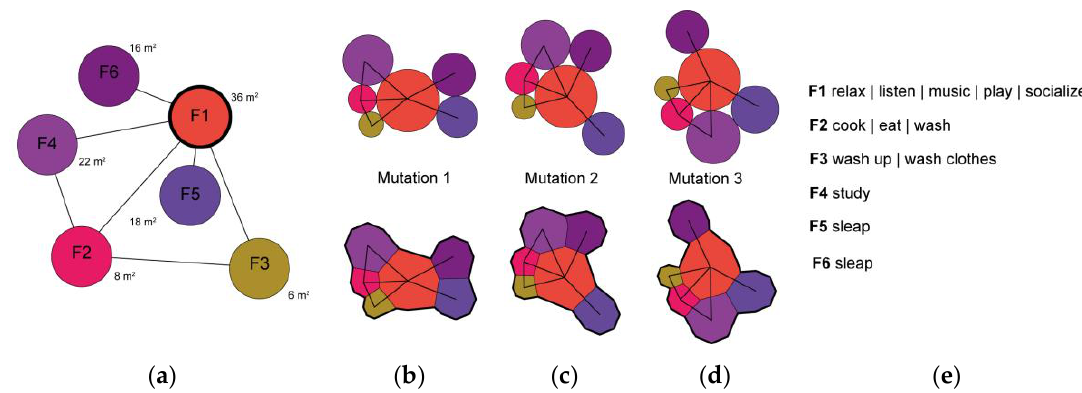
Figure 2. The example of variation keeping the same logical scheme: ( a ) The logical scheme; ( b ) First mutation; ( c ) Second mutation; ( d ) Third mutation; ( e ) The list of function.